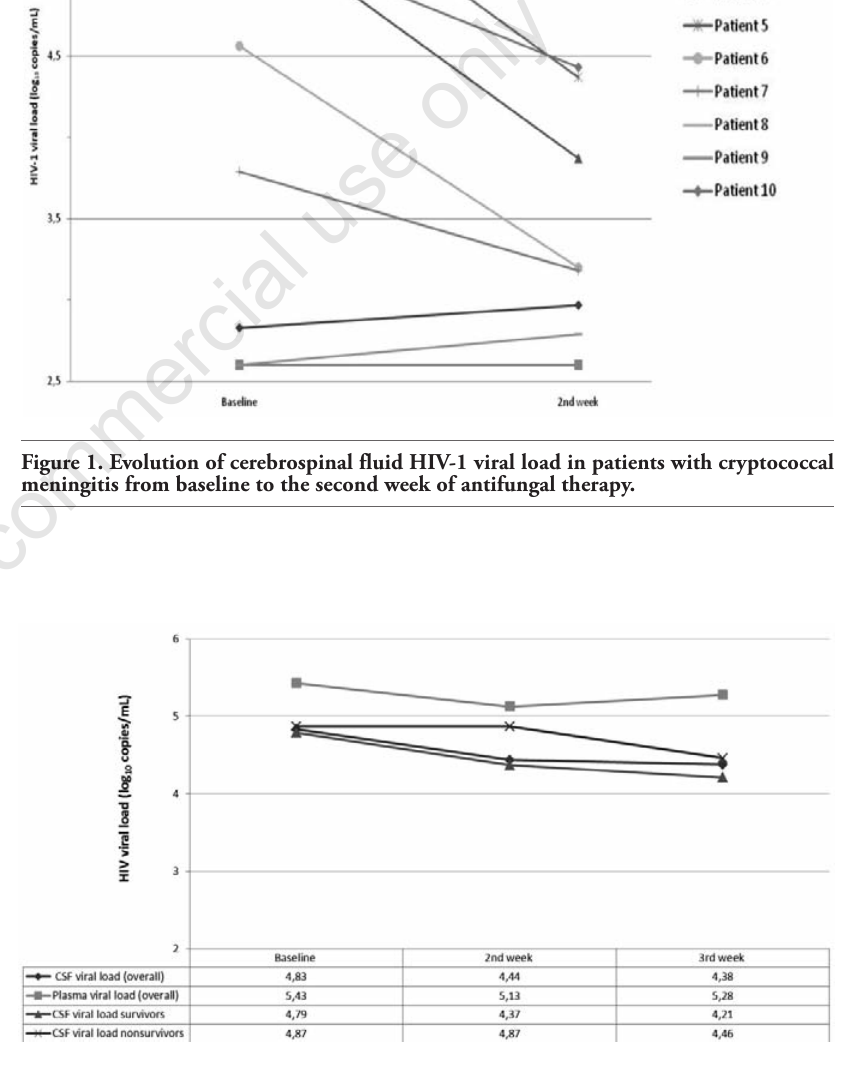
Figure 2. Three-week evolution of HIV-1 viral loads (median values) in the cerebrospinal fluid and plasma of 34 patients with cryptococcal meningitis. CSF viral load evolution is shown for the overall population and stratified by final outcome (last observation carried forward approach, see